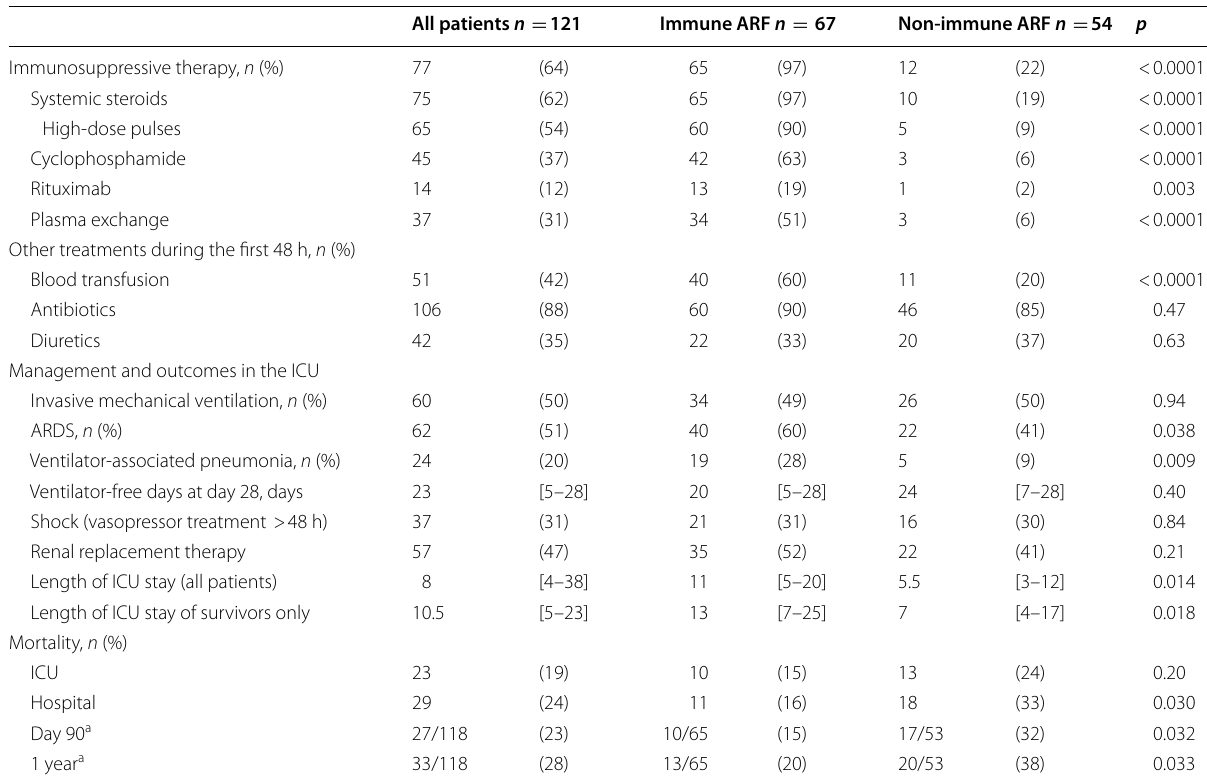
Table 3 Management during the ICU stay and outcomes of 121 patients with ARF associated with